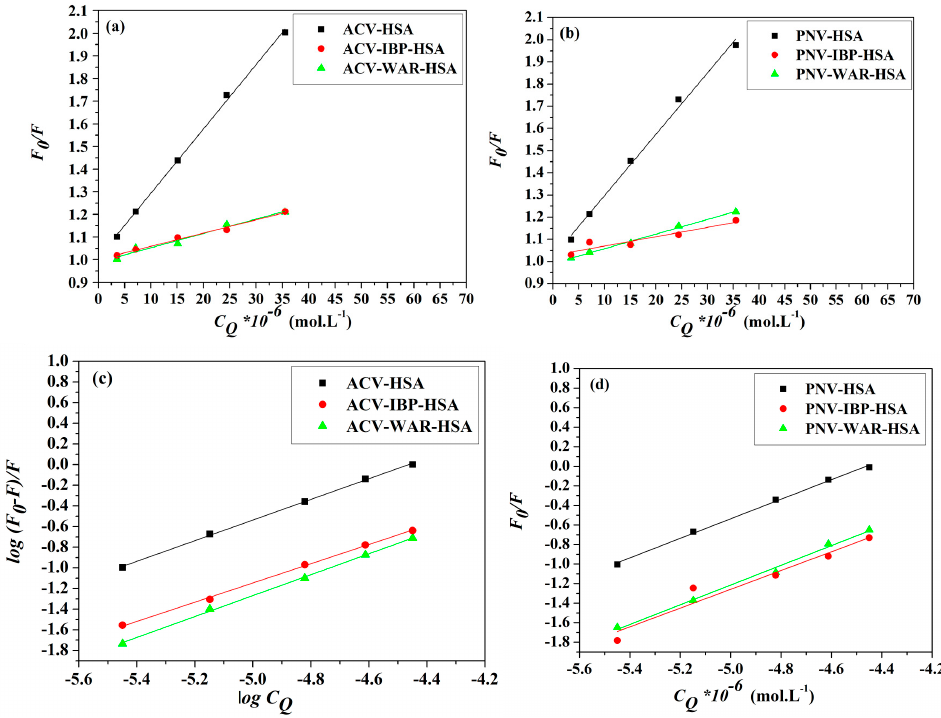
Figure 10. Stern–Volmer plots of ( a ) ACV ( b ) PNV and double log plots of ( c ) ACV and ( d ) PNV showing their interactions with HSA at 298 K, in the presence and absence of ibuprofen (IBP) and warfarin (WAR).